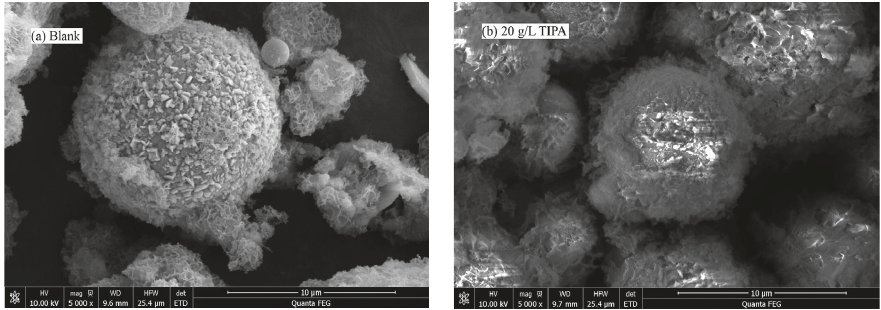
Figure 10: Morphology of FA immersed in pore solution for 60